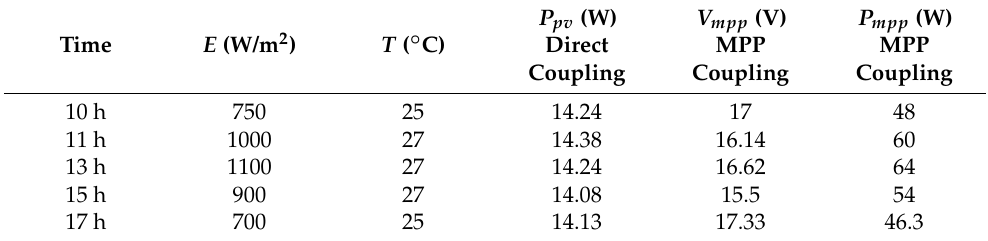
Table 7. Control by the FCC algorithm.